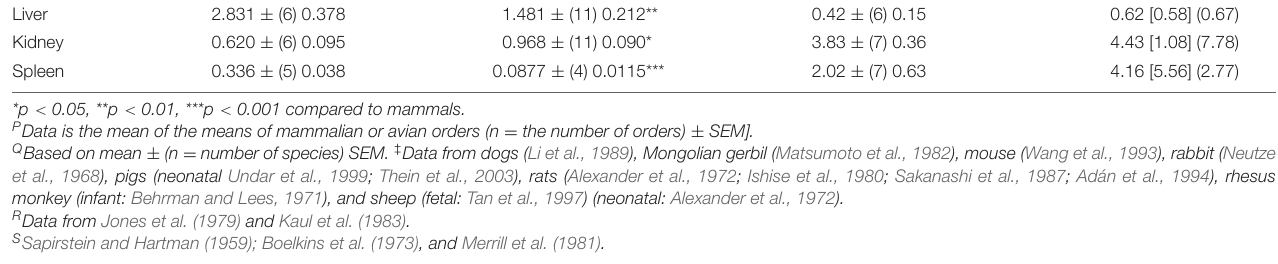
Frontiers in Physiology |